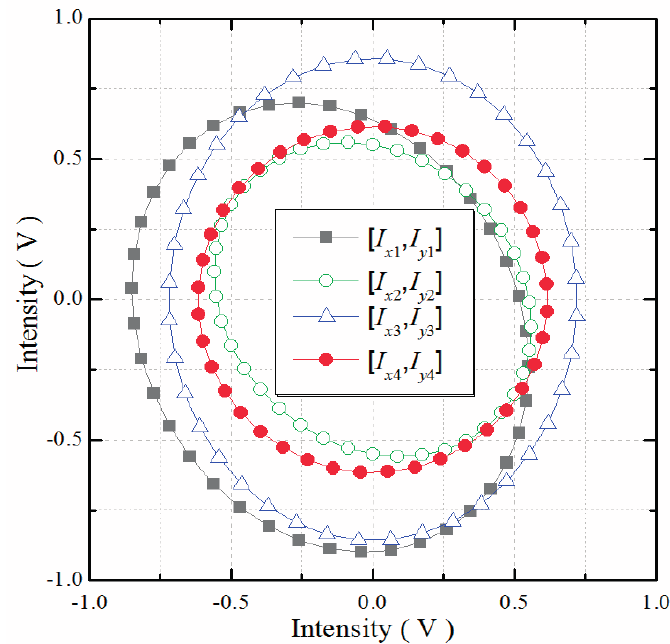
Figure 9. Lissajous trajectories of several pairs of quadrature signals during cyclic error compensation using the method proposed.